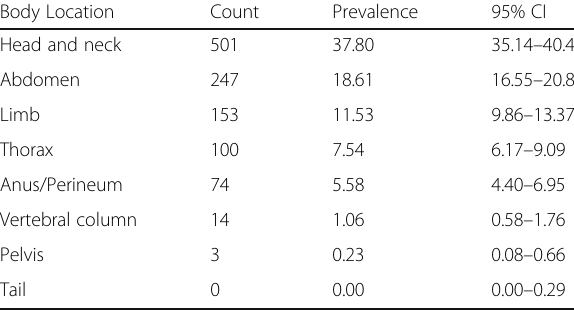
Table 4 Prevalence of body locations affected by at least